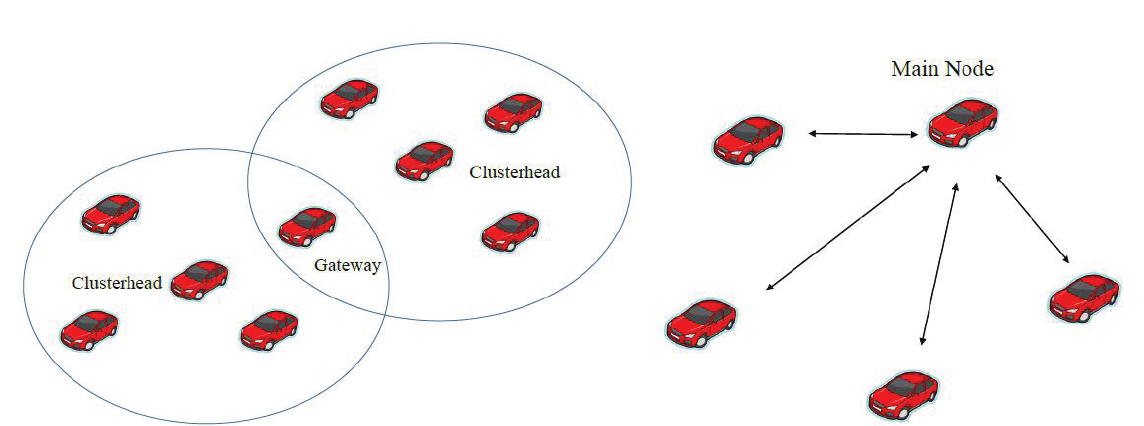
Figure 1. Cluster-based scheme ( Left ); distributed scheme ( Right